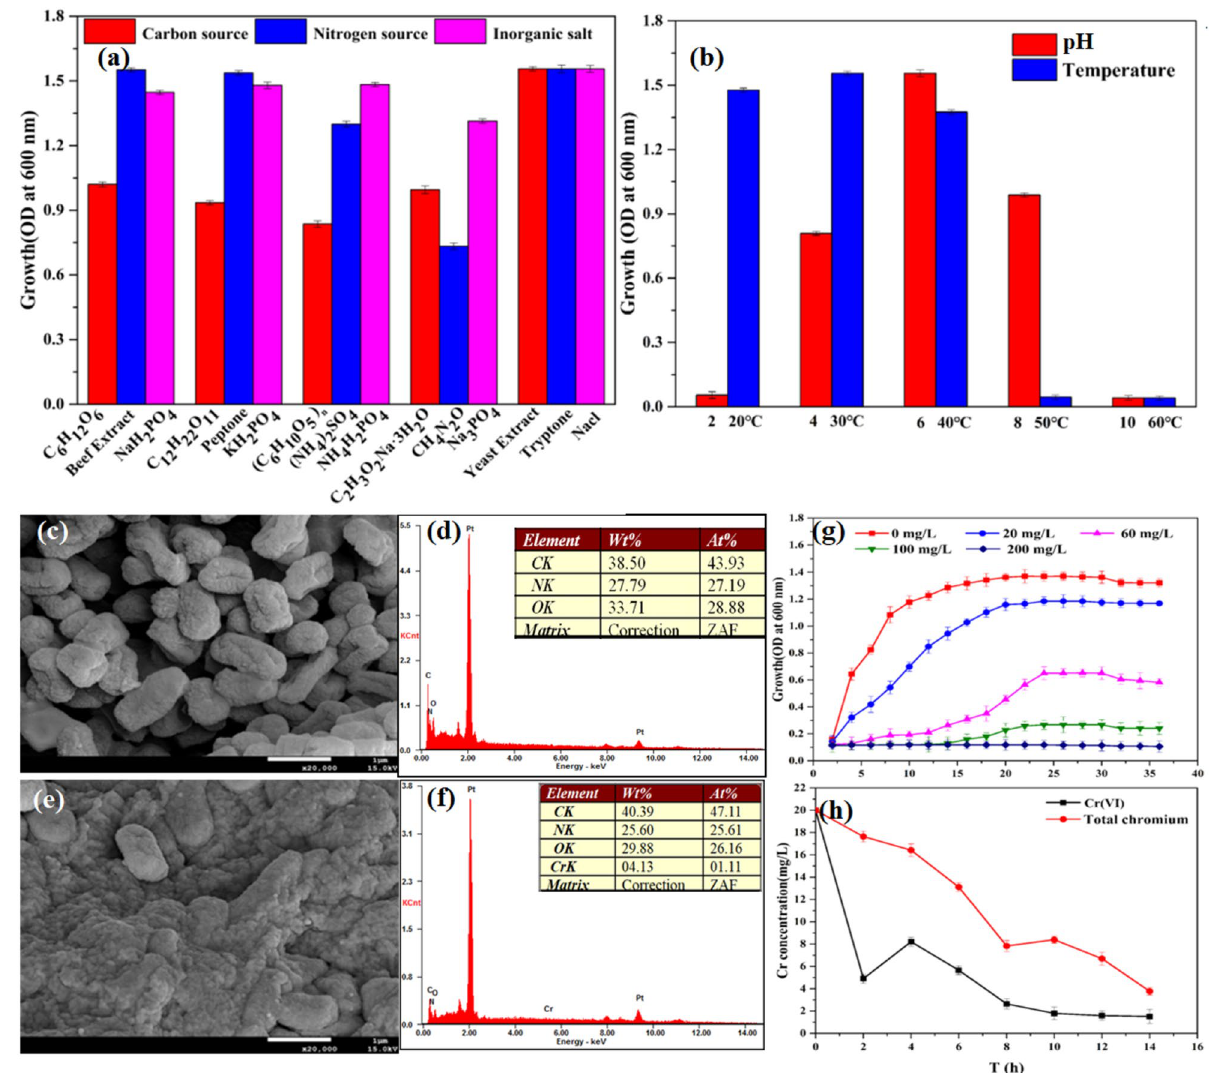
Figure 1. Optimization of growth conditions for K. variicola H12 ( a ) Energy substrate ( b ) pH and temperature; SEM–EDS analysis of ( c , d ) K. variicola H12 cultured with Cr(VI)-free and ( e – f ) K. variicola H12 cultured with Cr(VI) in LB medium for 24 h. ( g ) Effect of Cr(VI) concentrations on the growth of K. variicola H12 in LB medium. Experimental conditions: growth determined by cell turbidity measured at 600 nm. ( h ) Cr(VI) reduction experiment by K. variicola H12.